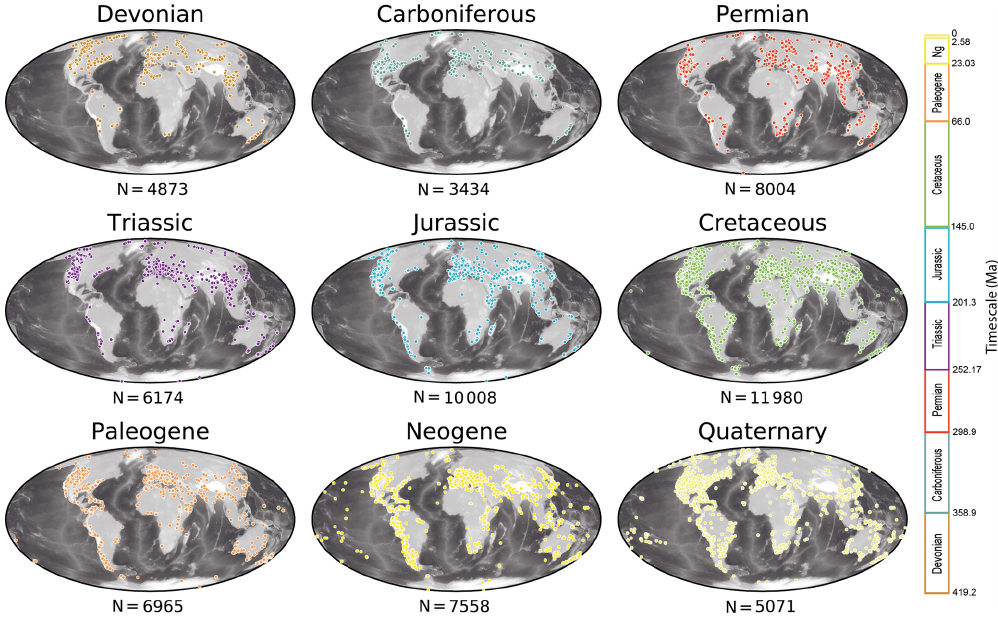
Figure 1. Global distributions and number of fossil collections since the Devonian. The greyscale background shows global present-day topography ETOPO1 (Amante and Eakins, 2009) with lighter shades corresponding to increasing elevation. Fossil collections from the PBDB are colored following the standard used by the International Commission on Stratigraphy.